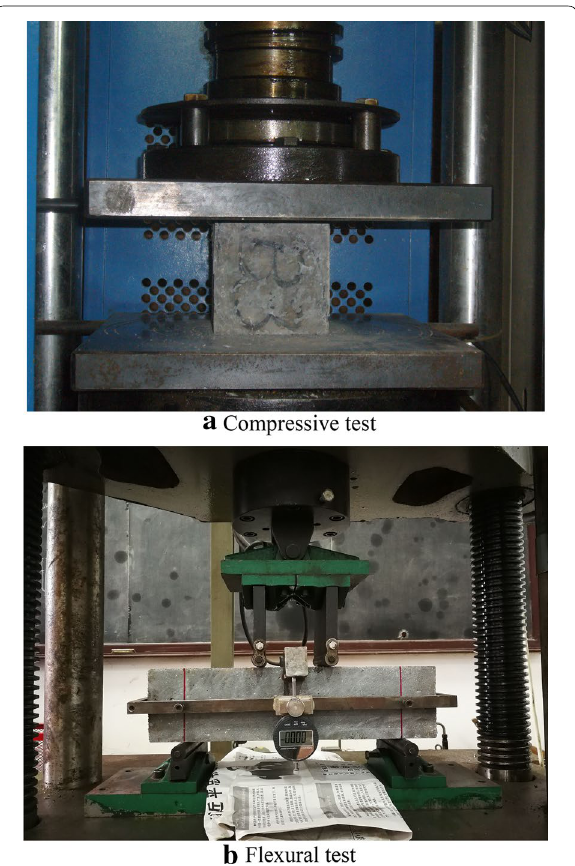
Fig. 6 Loading scheme and photographs of the UHPC material tests.